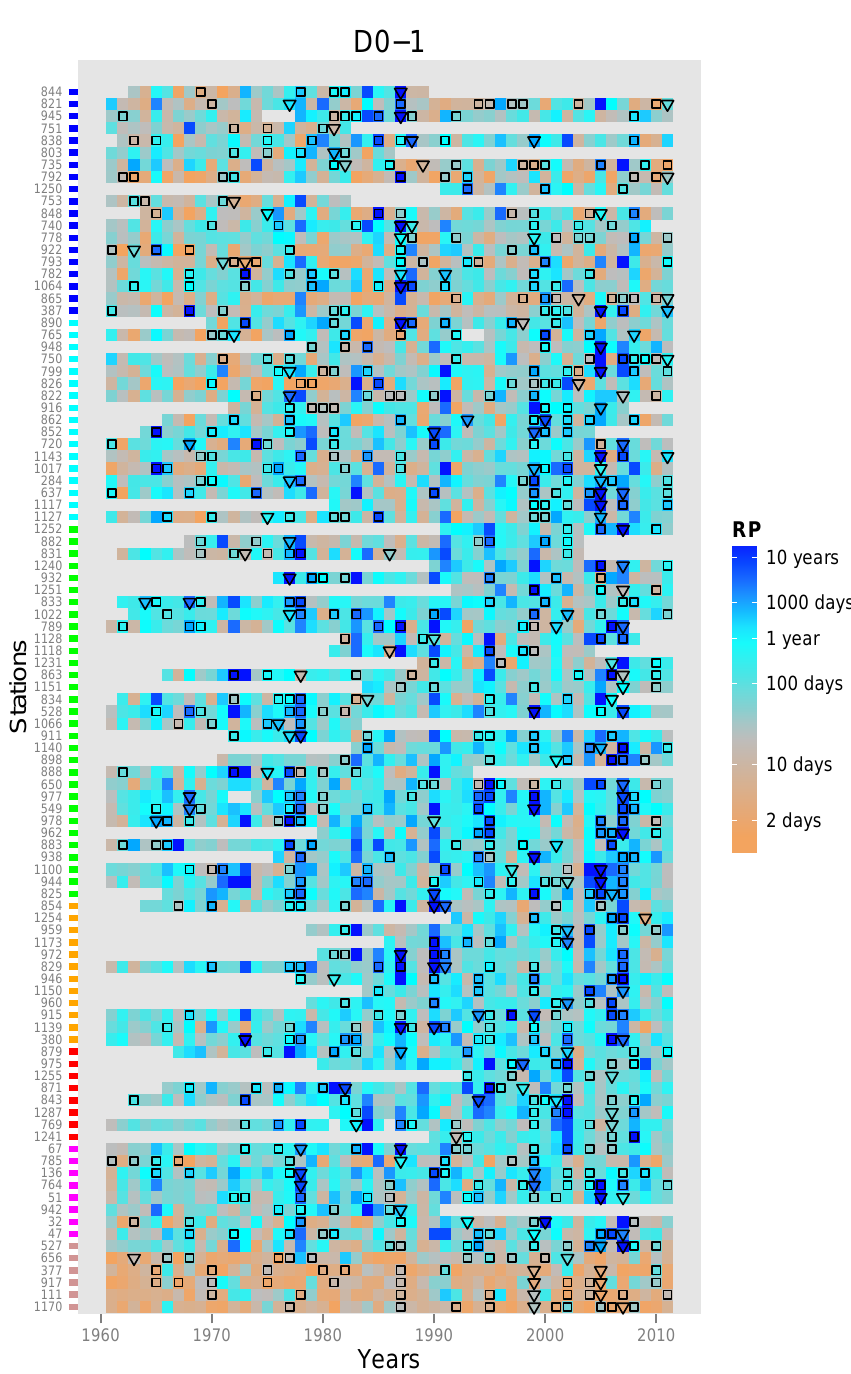
Figure 4. Overview of all flood events. All river discharge stations (numbers on the y axis, see Table 3) cover at least 20 years in the 1961–2011 period. For each annual discharge peak, the return period of the 2-day precipitation sum (D0–1) is indicated by colors. HQ5s and HQ20s are marked with squares and triangles, respectively. The catchments are sorted by regime type and by increasing size from top to bottom. Hydrological regimes are indicated by colors: blue = Glacial, cyan = Nival, green = Pluvial, orange = Jurassien, red = Meridional, magenta = Macro, brown = Lake